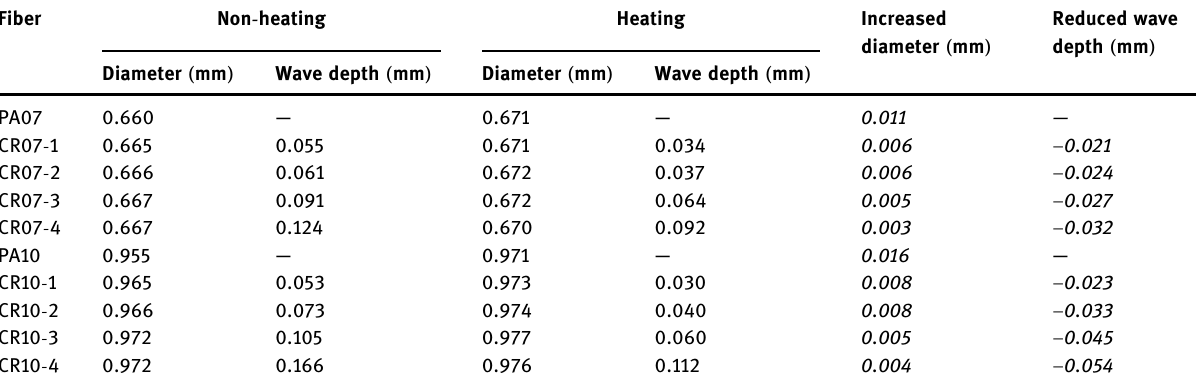
Table 1: Dimensions of paddled and crimped fi bers Fiber